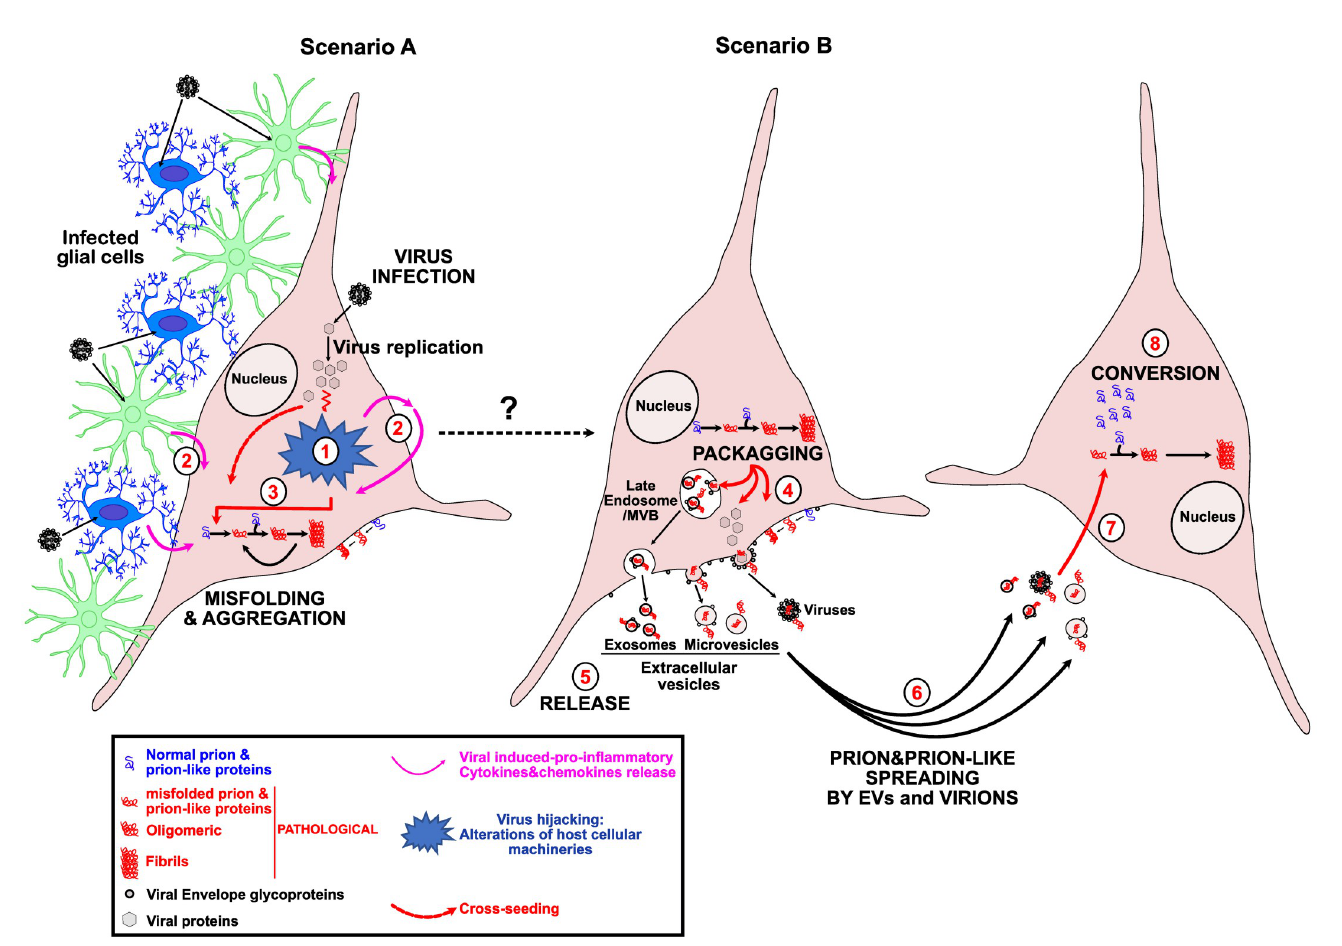
Fig 1. Virus infection and step-by-step misfolding and aggregation, spreading, and prion-like conversion. Scenario A : Viruses hijack the host cellular machineries and pathways for their own benefit to efficiently drive their replication. To this end, viruses developed different strategies to impair intracellular trafficking like nucleocytoplasmic export, the endo-lysosomal secretory and degradation pathways as well as all the machineries involved in protein quality control and in proteostasis (1). In response to infection, infected host cells, including glial cells, reply through the expression of restriction factors and secretion of proinflammatory cytokines and chemokines (2). Inactivation of protein quality control and induction of neuroinflammation are major events leading to the misfolding and aggregation processes of ND- associated proteins like PrP, α -Synuclein, APP/A β , Tau, TDP-43, and FUS (3). Scenario B : Misfolded pathological proteins can have different etiology. They can be induced by aging, by mutations in susceptibility genes or ND-associated genes themselves, or by environmental stressors such as pathogens-like viruses (see dotted black line) or repeated contacts with chemicals. In virus-infected cells, misfolded proteins can be secreted in EVs that bud from the plasma membrane (microvesicles and viral particles) or from the surrounding membrane of MVBs (exosomes) (4). Like viral particles, EVs are released (5) in presence or absence of viral Envelope glycoprotein at their surface, conferring broadened cell tropism and increased endosomal escape essential for efficient spreading (5, 6). Viral particles and EVs containing pathological protein aggregates enter target cells through different mechanisms, including the one mediated by the interaction between the viral Envelope glycoprotein and its host membrane receptor (7). Once introduced into the target cells, protein aggregates induce the conversion of their normal counterpart into aggregated isoforms through a conformational templating mechanism (8). EV, extracellular vesicle; MVB, multivesicular body; ND, neurodegenerative disease. https://doi.org/10.1371/journal.ppat.1010670.g001 PLOS Pathogens| https://doi.org/10.1371/journal.ppat.1010670 August 4,